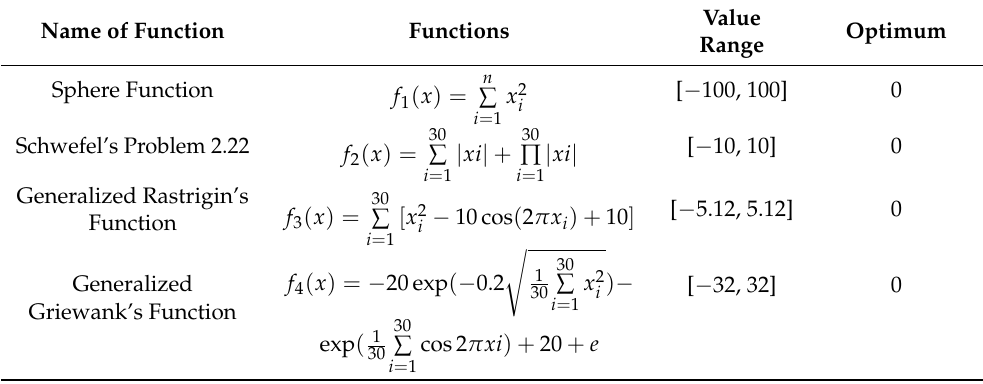
Figure 3. Sphere function optimization curve.